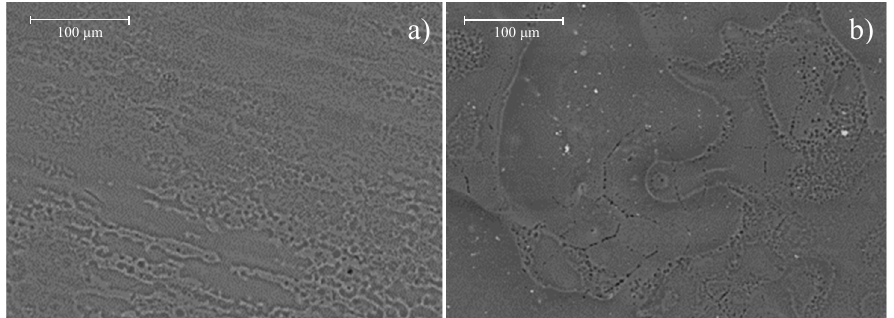
Figure 14. SEM images of the topography of heat-treated ( a) Mg-0.375Ga, ( b ) Mg-0.750Ga after immersion in SBF for168 h.